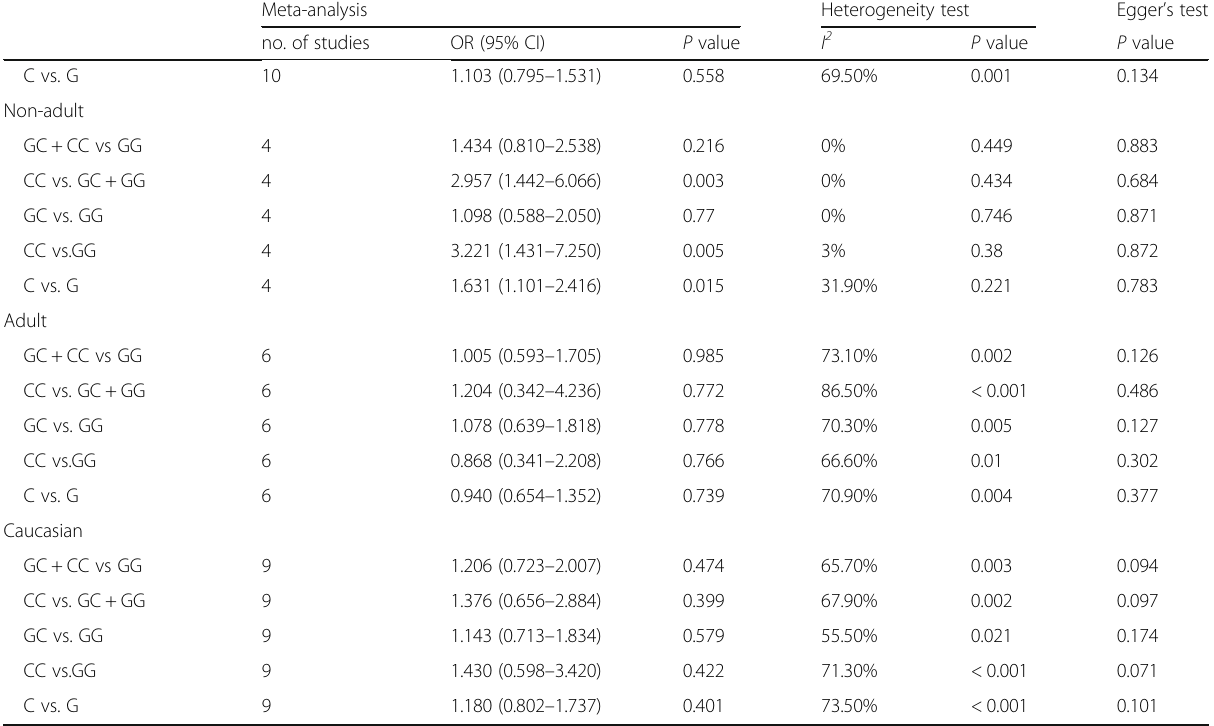
Table 2 Results of the meta-analysis, heterogeneity test and Egger ’ s test